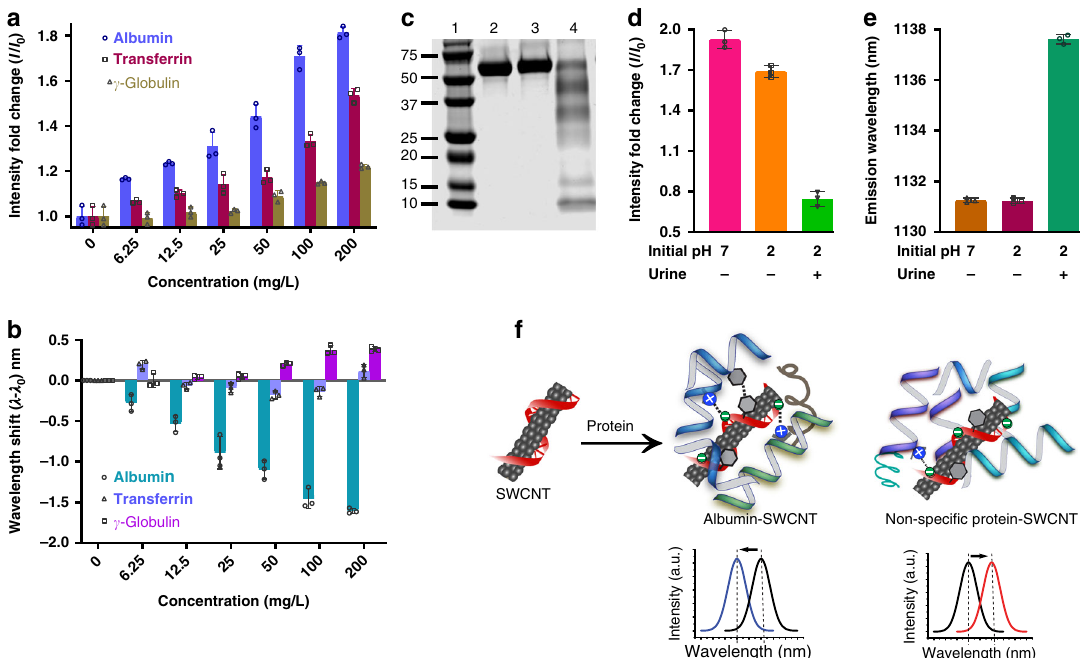
Fig. 2 Sensor response to interferents, and sensor mechanism. a Emission intensity response of the nanosensor to various proteins. b Emission wavelength response of the nanosensor to protein interferents. c SDS-PAGE gel where: lane 2 contains albumin at pH 7 incubated at room temperature for 30 min; lane 3 contains albumin incubated at pH 2 in PBS at room temperature for 30 min followed by neutralization; lane 4 contains albumin incubated in urine at pH 2 for 30 min followed by neutralization. d Emission intensity response of the nanosensor to intact albumin (bars 1 – 2, corresponding to lanes 2 – 3, respectively, in panel c ) and degraded albumin (bar 3, corresponding to lane 4 in panel c ). e Emission wavelength response of the nanosensor to intact albumin (bars 1 – 2, corresponding to lanes 2 – 3 in panel c ) and degraded albumin (bar 3, corresponding to lane 4 in panel C). f A proposed model of albumin interaction with the carboxy-PCD-SWCNT nanosensor. Data in panels a , b and d , e present the (9, 4) nanotube chirality. Error bars represent standard deviation for n = 3 technical